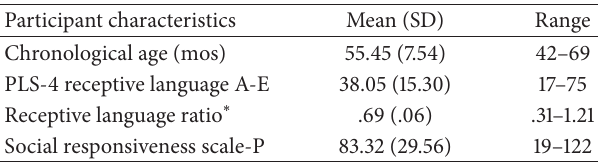
Table 1: Sample characteristics.